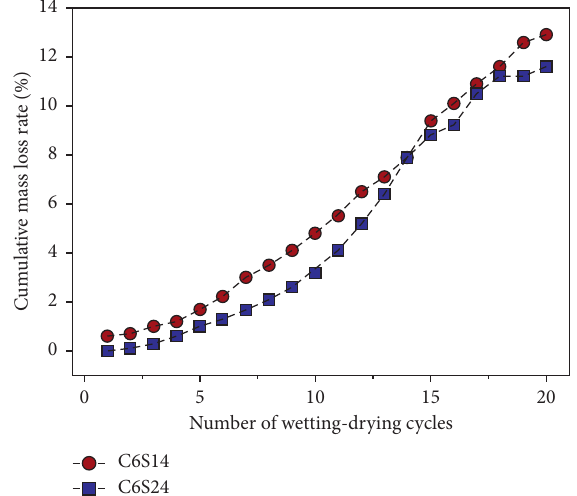
Figure 9: Evolutions of the cumulative mass loss rate with wetting- drying cycles of stabilized Cr-contaminated soils.